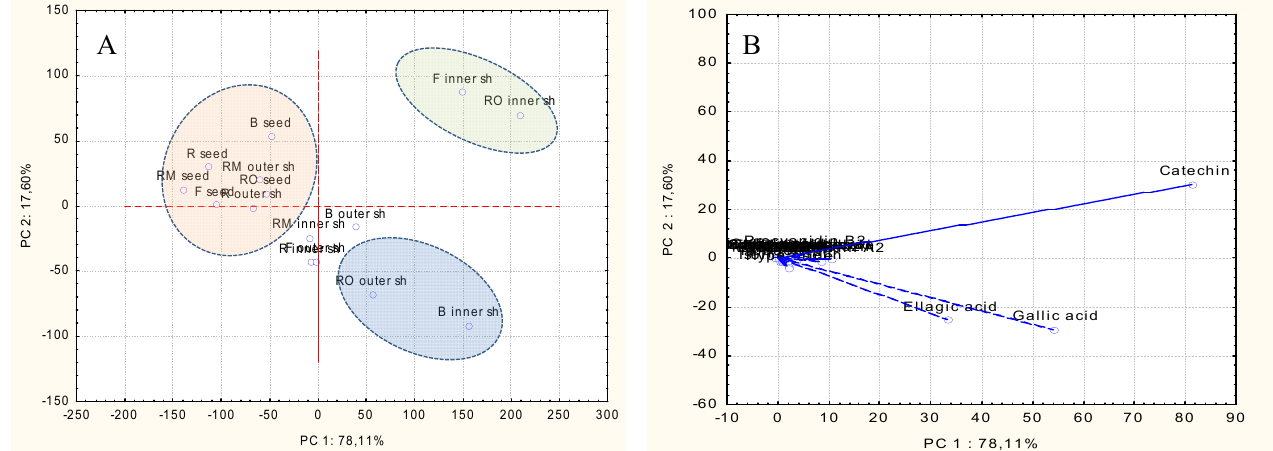
Figure 4. ( A ) The PCA score plot representing the distribution of the roasted, boiled, and fried groups of chestnut seed and shell samples. ( B ) The PCA loading plot demonstrating the correlation between the 25 individual phenolic variables of the chestnut matrix.